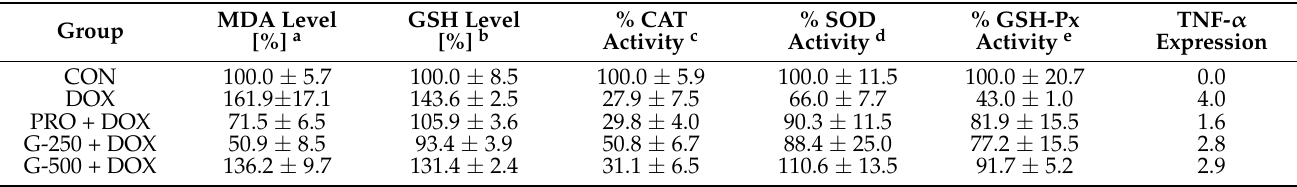
Table 4. Levels of cardiotoxicity biomarkers in rats treated with DOX in combination with probucol (PRO) or garlic homogenate (G-250, G-500) [52]. Group